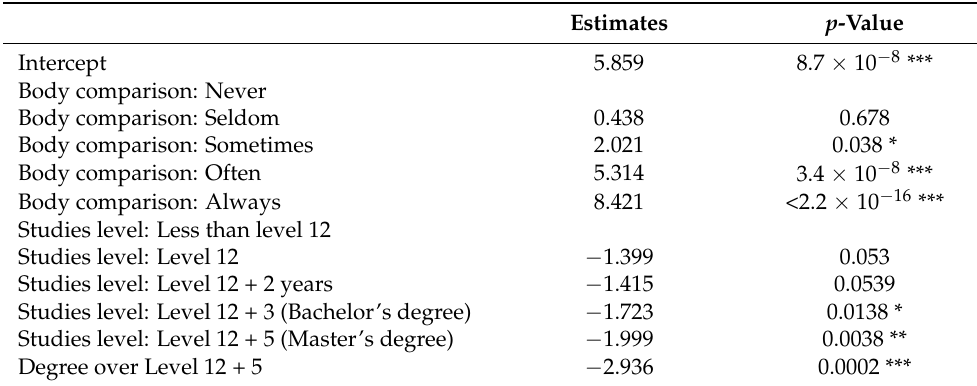
Table 9. Linear regression looking for a link between EDI-DT score and frequency of comparing one’s own physical appearance to that of people followed on social media.